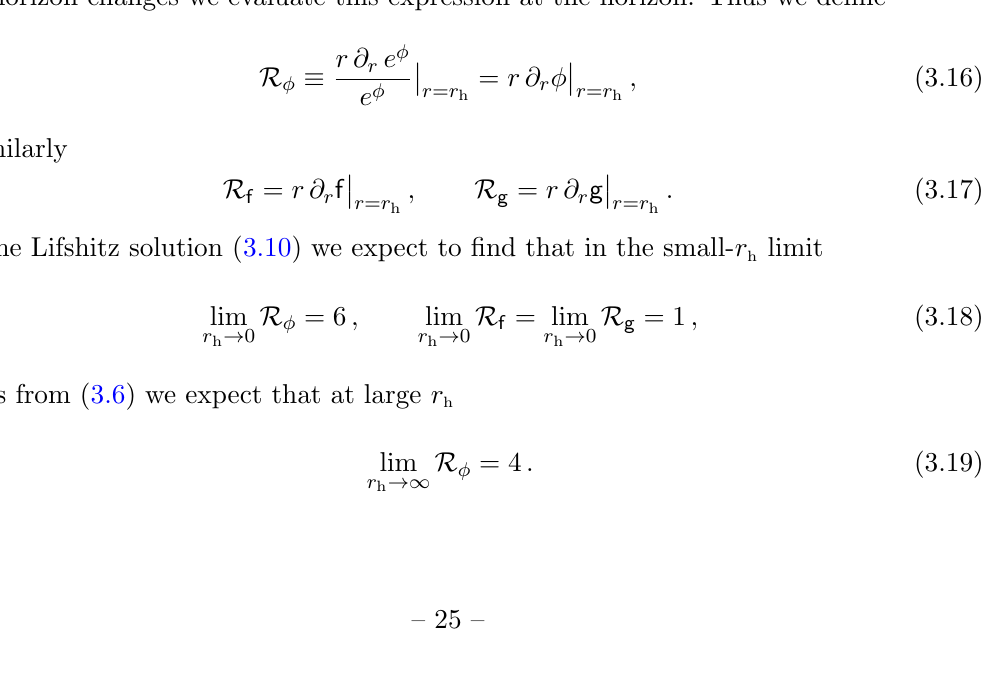
for di(cid:11)erent values of 2